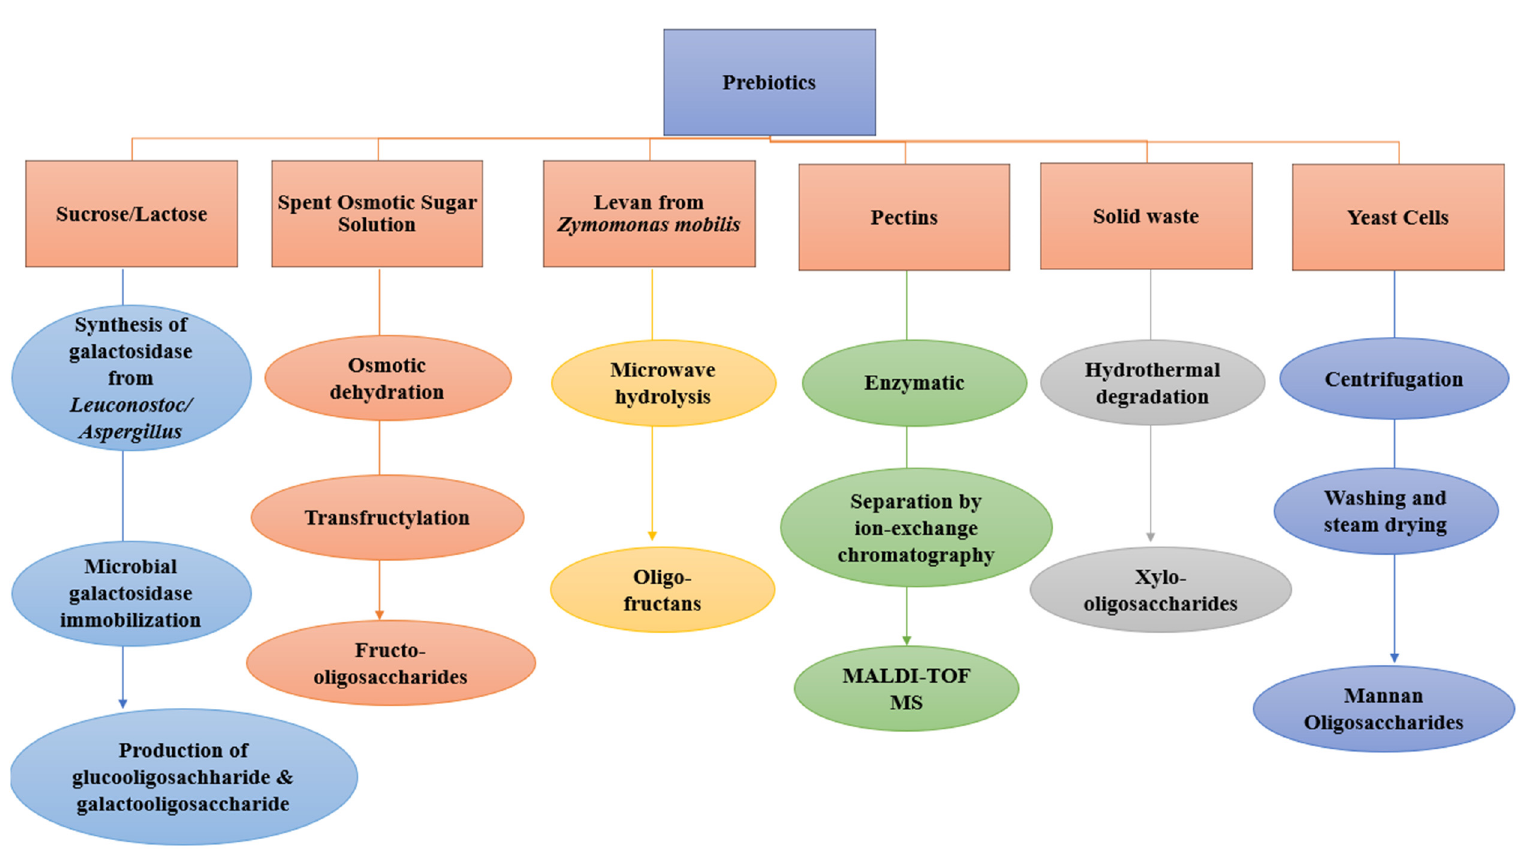
Figure 1. Different methods of producing prebiotics.